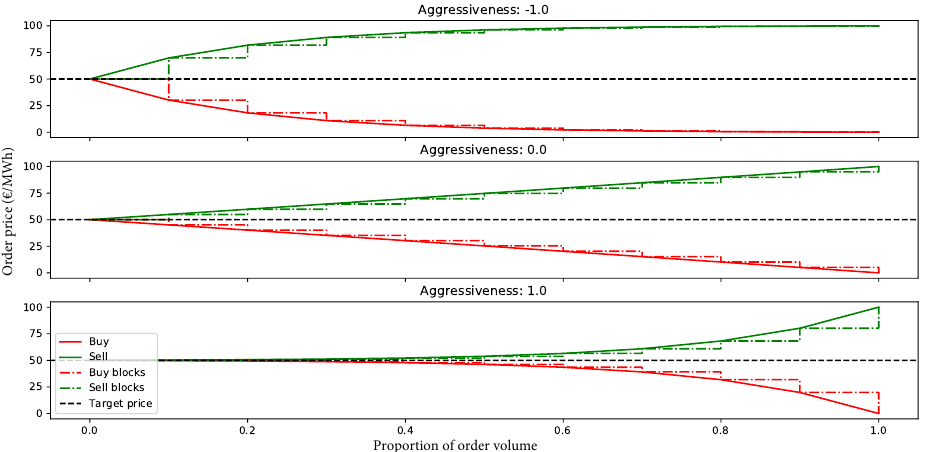
Figure 4. Illustration of MTAA price–volume curve (order price vs. proportion of order volume to be posted in the CID